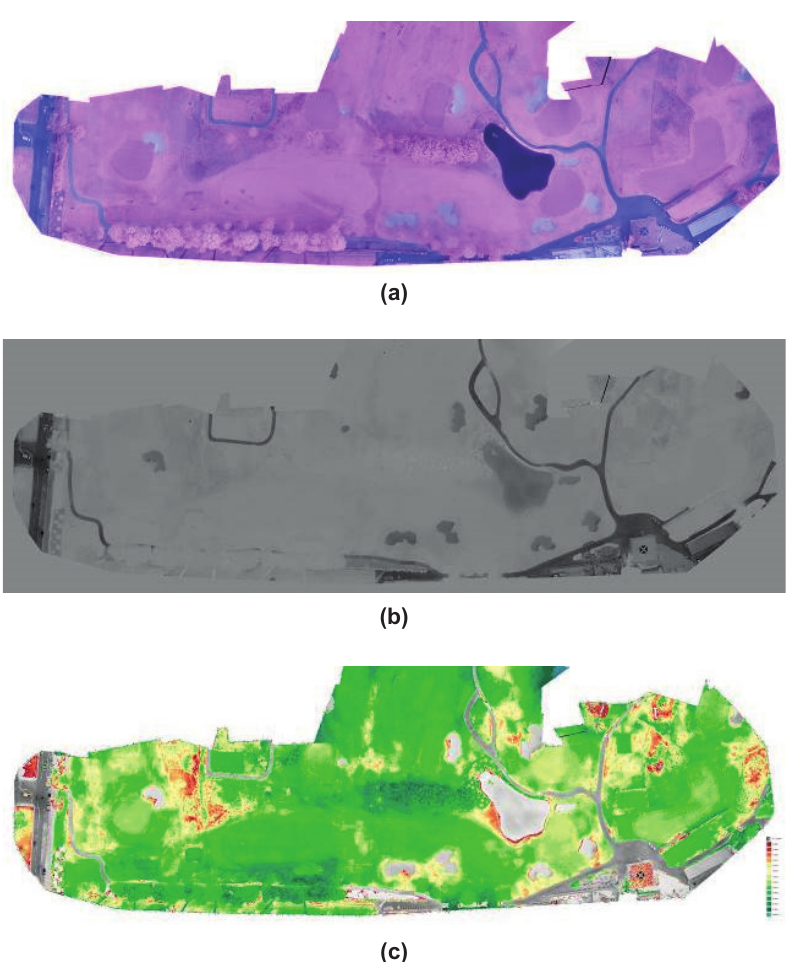
Figure 11. NDVI computation procedure example: multi-spectral ( a ), NDVI gray-scale ( b ) and NDVI color-map ( c )